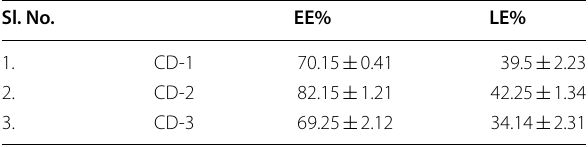
Table 2 Encapsulation efficiency (EE %) and loading CD-2 and CD-3 NPs